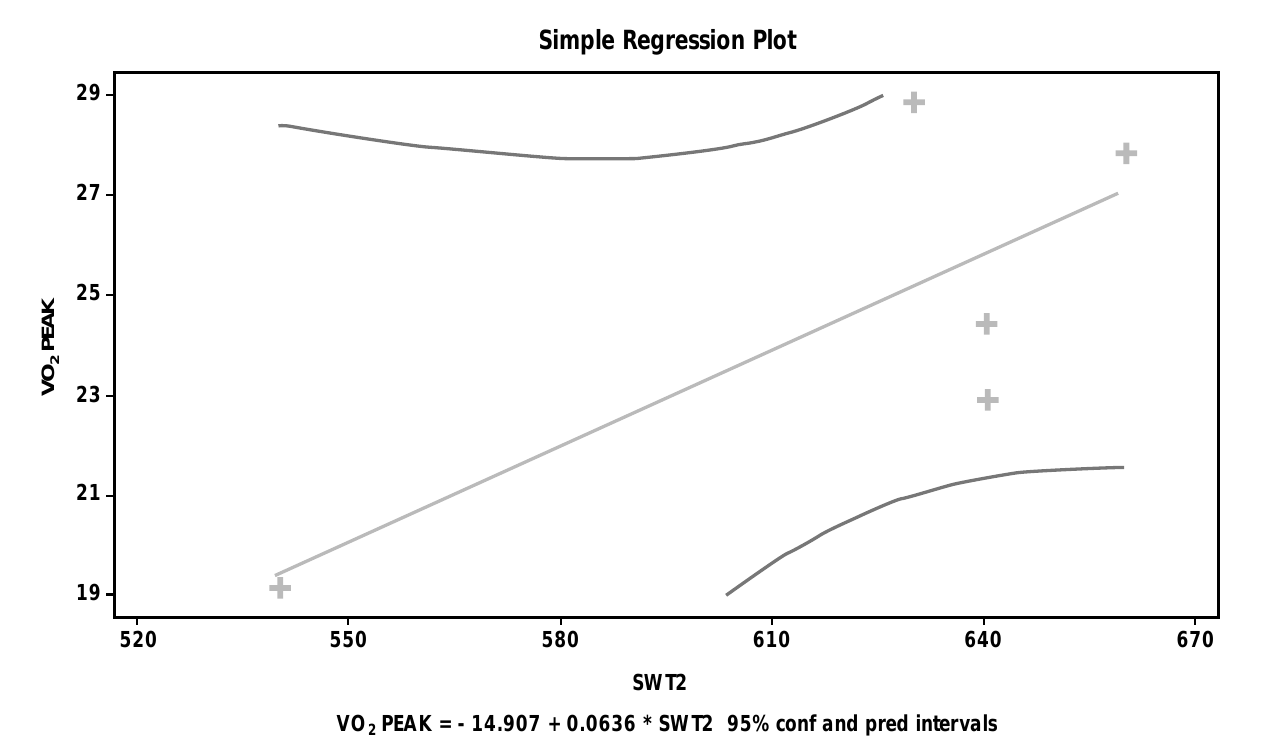
Graph 1.Simple regression plot with 95% confidence intervals for directly measured VO 2 peak (ml/kg/min) and distance (m) achieved in the shuttle walking Simple Regression Plot